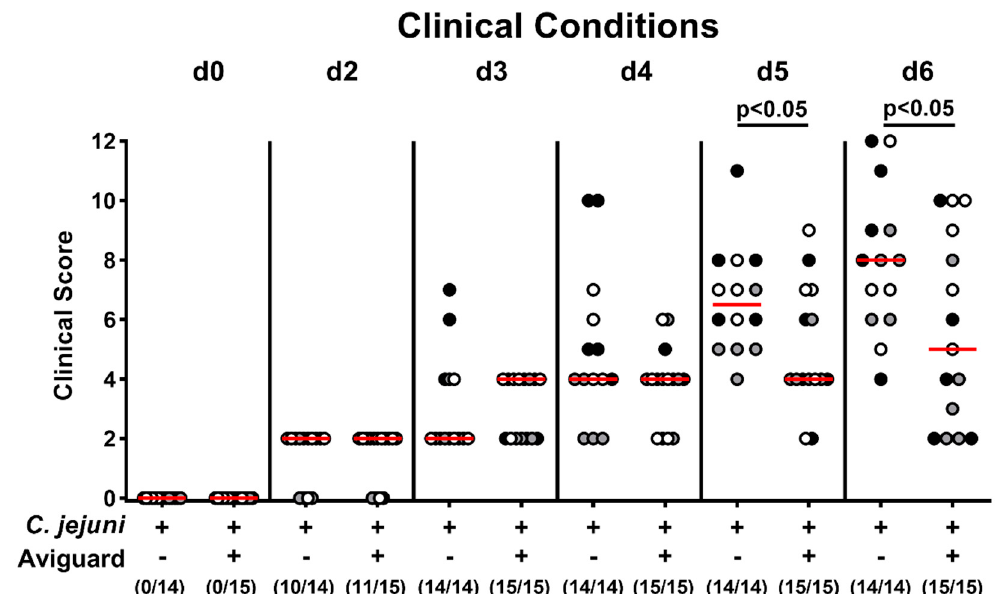
Figure 3. Aviguard ® treatment and clinical outcome in C. jejuni -infected microbiota-depleted IL-10 − / − mice. Following C. jejuni strain 81-176 infection on day (d) 0 and d1, microbiota-depleted IL-10 − / − mice were perorally treated with Aviguard ® or placebo on d2, d3, and d4. Prior and at defined time points post either infection, the clinical outcome was quantified in each mouse by a standardized clinical scoring system. Median (red bars), significance levels ( p values) determined by the Mann Whitney U test, and numbers of clinical score-positive mice out of the total number of analyzed animals (in parentheses) are given. Data were pooled from three independent experiments (as indicated by black, white, and gray circles).